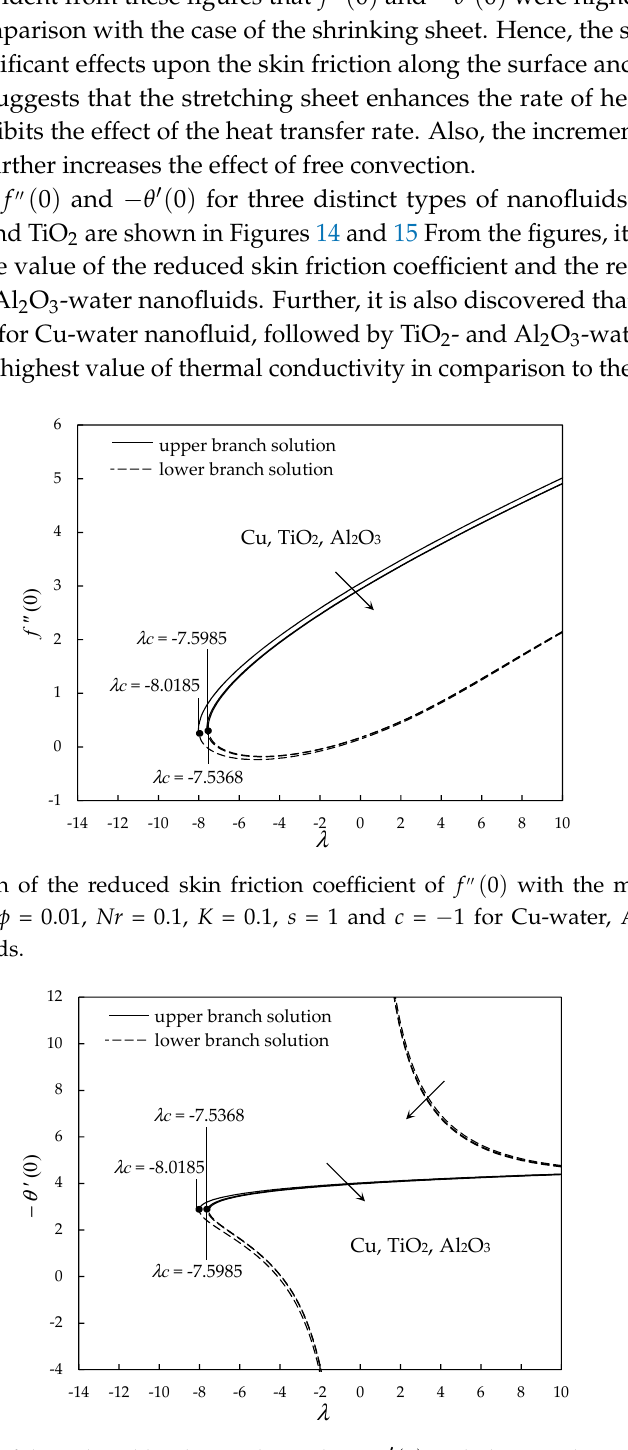
Figure 13. Variation of the reduced local Nusselt number −𝜃′(0) with the mixed convection parameter 𝜆 for various values of c (stretching sheet) when 𝜙 = 0.01, Nr = 0.1, K = 0.1 and s = 1 for Cu-water nanofluid.